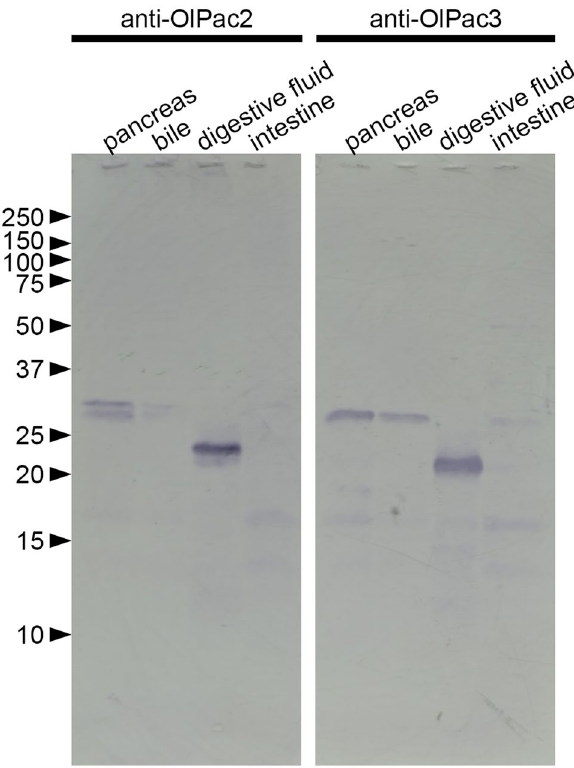
Figure 7. Western blot analysis of pactacin. Medaka extracts of the mesentery including pancreas (labeled as pancreas), intestines, bile and digestive fluid with anti-OlPac2 antibody or anti-OlPac3 antibody. Numbers on the left refer to molecular weights (kDa) of molecular markers. Full-length blots are shown, and original figures including marker lane are included in a Supplementary